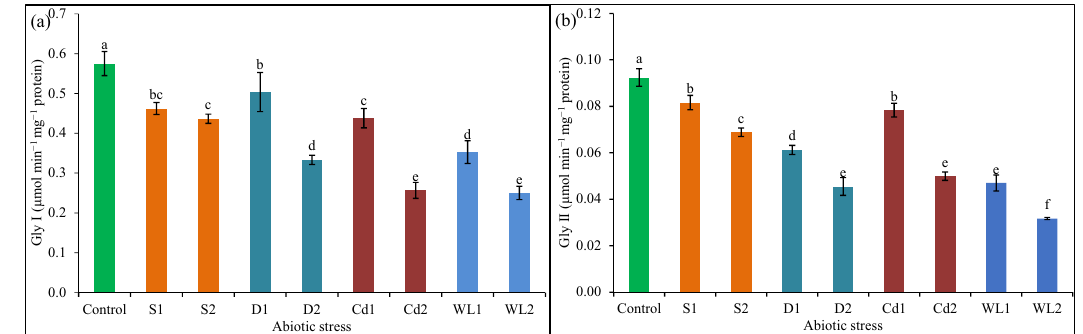
Figure 8: Gly I ( a ) and Gly II ( b ) activities of C. olitorius plants a ff ected by di ff erent abiotic stresses. S 1 , S 2 , D 1 , D 2 , Cd 1 , Cd 2 , WL 1 , and WL 2 represent 200 mM of NaCl, 400 mM of NaCl, 10 days of water de fi cit, 15 days of water de fi cit, 2 mM of CdCl 2 , 4 mM of CdCl 2 , 5 days of waterlogging, and 15 days of waterlogging, respectively. Mean value (± SD ) was calculated from three replicates for each treatment. Values in a column with di ff erent letters are signi fi cantly di ff erent at p ≤ 0.05 applying